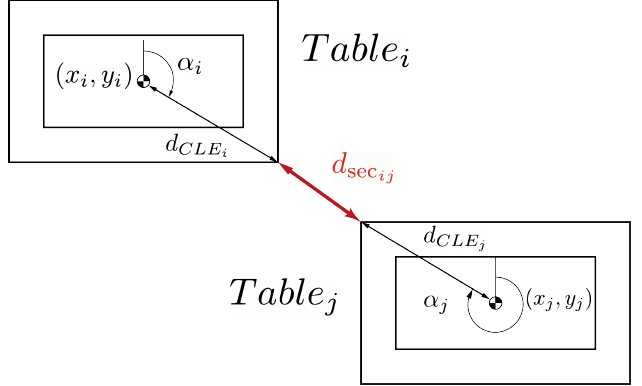
Figure 2. Table interaction for the TLP in hostelry tables. The security distance d sec from the tables centre of reference. d CLE intersection of the CLE with the table-to-table